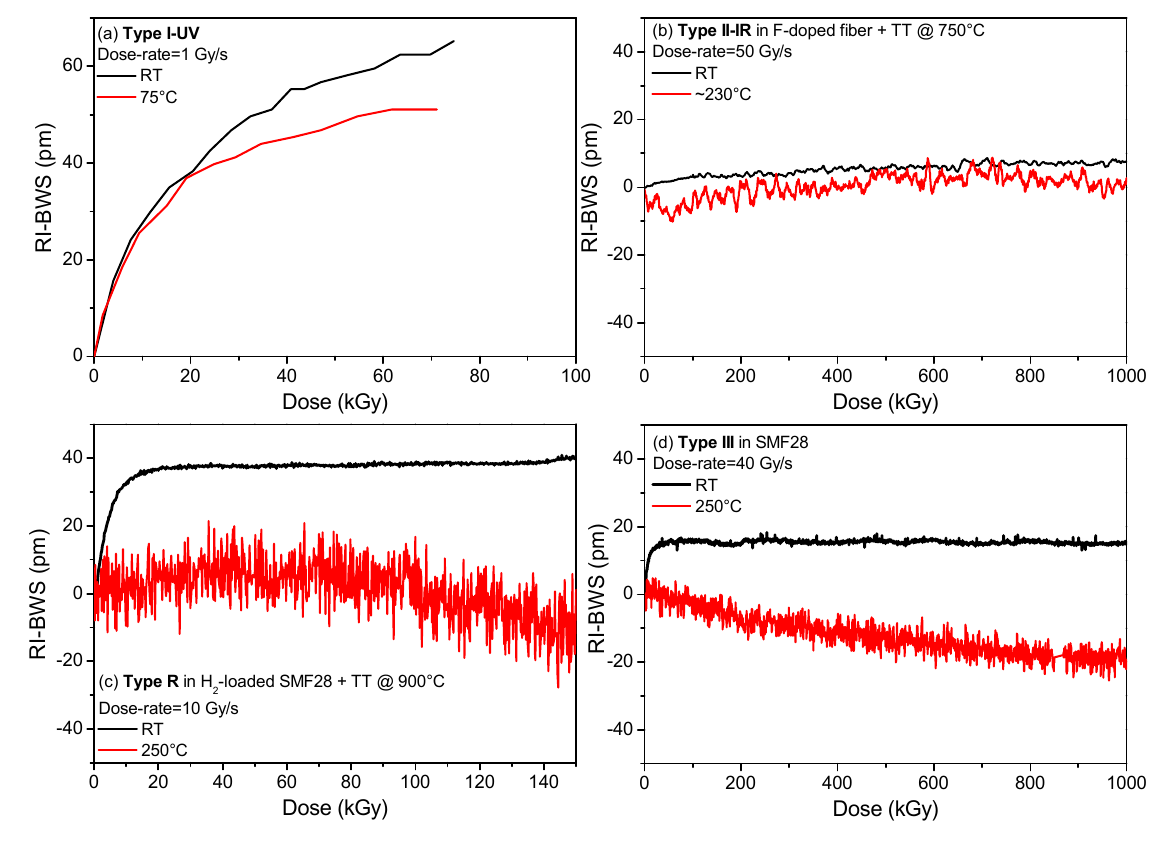
Figure 13. RI- BWS as a function of the dose, at two different temperatures, for different FBG types: ( a ) a type I FBG written with a UV laser (at 248 nm) in an H 2 -loaded Ge-doped fiber (SMF28e) treated at 240 ◦ C for 3 min and at 100 ◦ C for 3 days, with a dose rate of about 1 Gy/s; ( b ) a type II FBG in an F-doped fiber with an fs-IR laser (centered at 800 nm, with a pulse width of 50 fs) treated at 750 ◦ C for 15 min, with a dose rate of 50 Gy/s; ( c ) type R FBGs in SMF28 fiber regenerated at 900 ◦ C, with a dose rate of 10 Gy/s; ( d ) a type III in the SMF28 fiber written PbP with an fs-IR laser (at 800 nm, a pulse width < 120 fs, and pulse energy of 230 nJ), with a dose rate of 40 Gy/s. The gratings reported in ( a ) were investigated under γ -rays, whereas all the others were obtained under X-rays. Data extracted from [80,81,86,89].